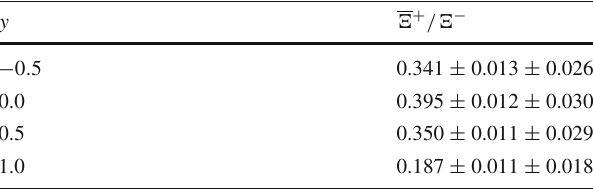
Table 6 Ratio of p T integrated yields versus rapidity of (cid:2) + and (cid:2) − produced in inelastic p+p interactions at 158 GeV / c beam momentum. Rapidity values correspond to the middle of the presented bin. First value is the ratio, second represents the statistical uncertainty and third one corresponds to the estimated systematic uncertainty